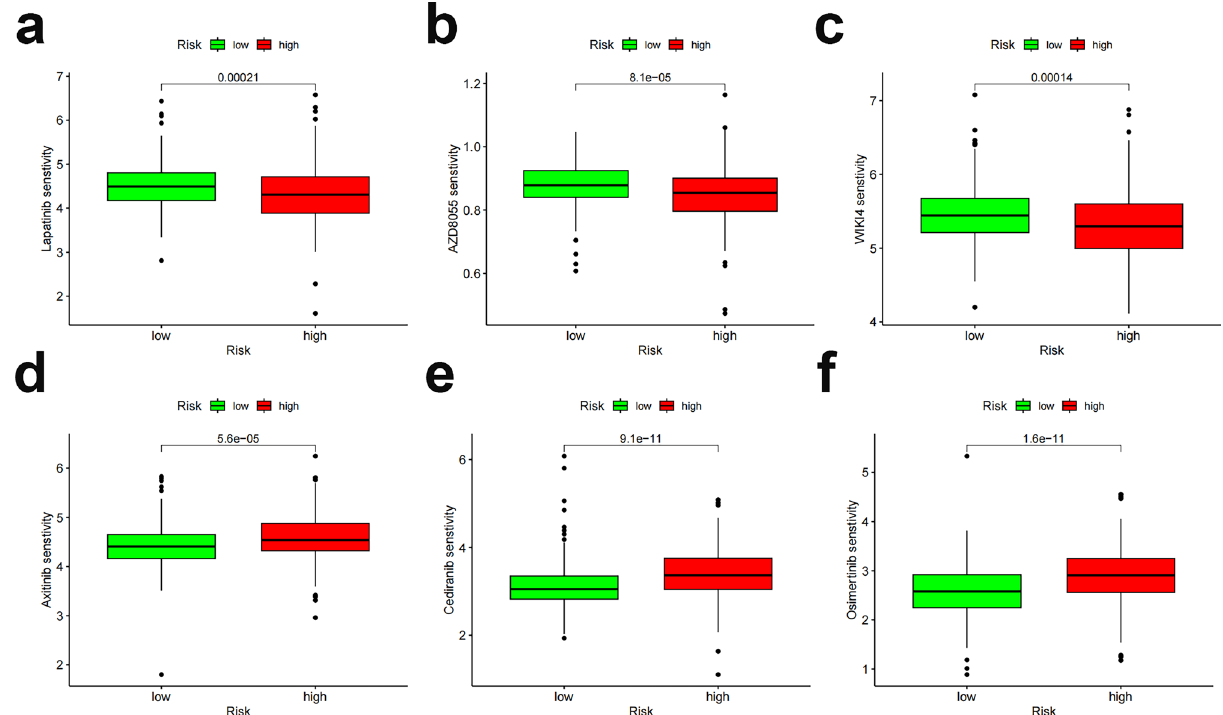
Figure 12. Drug sensitivity analysis. ( a – c ) Predicted sensitivity scores for lapatinib, AZD8055, and WIKI4 as chemotherapy candidates for patients with high FAM-related lncRNA scores. ( d – f ) Axitinib, cediranib, and osimertinib are candidates for patients with low scores. *p < 0.05; **p < 0.01; ****p <